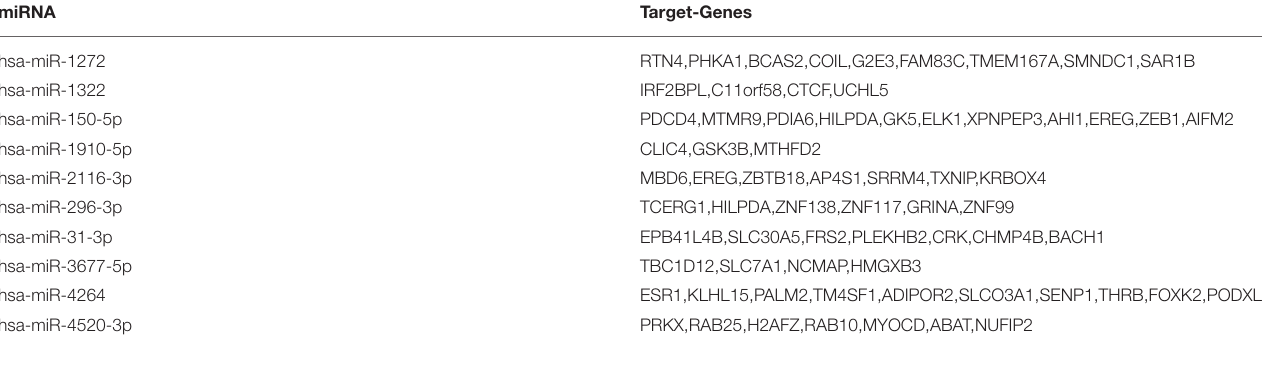
TABLE 2 | Target genes of the first 10 miRNAs in hsa_circ_0008234. miRNA Target-Genes